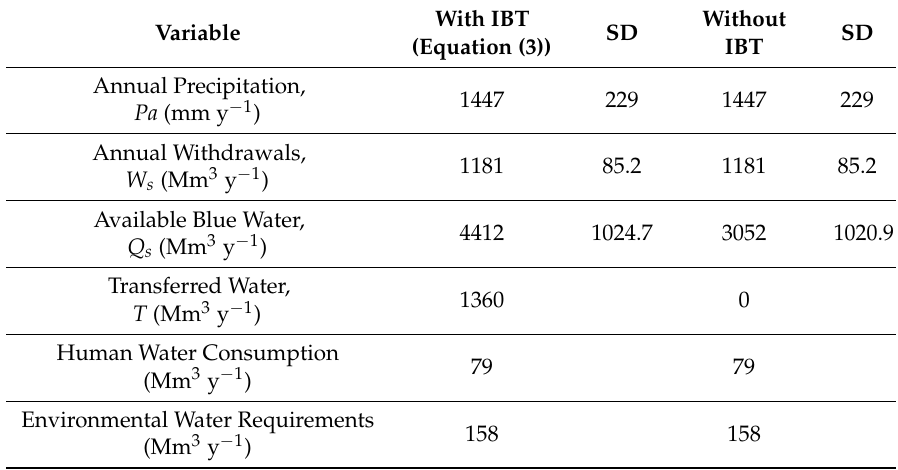
Table 3. Computed local estimates of variables with and without IBT for the Arakawa river basin (1985–2009).